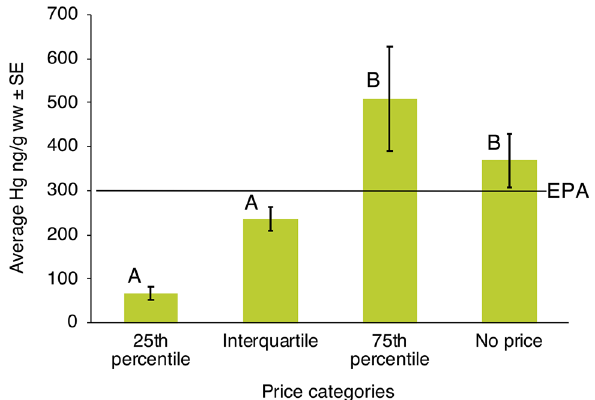
Figure 3. Average ± SE mercury content by price (Peruvian Nuevos Soles [PEN] per kilogram). Samples were grouped into four categories based on price: Below the 25th percentile (1–4.3 PEN); Interquartile (4.6–12.3 PEN); Above the 75th percentile (13.6–42.5 PEN); and No price available. Different letters above bars indicate which averages are significantly different using Tukey’s post-hoc tests.